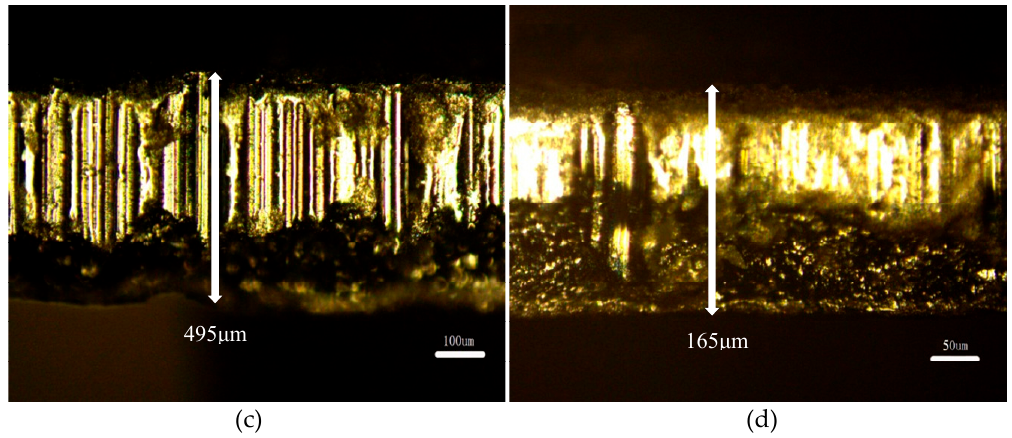
Figure 5. The view of 3DG: ( a ) top view before assembly; ( b ) top view after assembly; ( c ) cross-sectional view before assembly; ( d ) cross-sectional view after assembly.